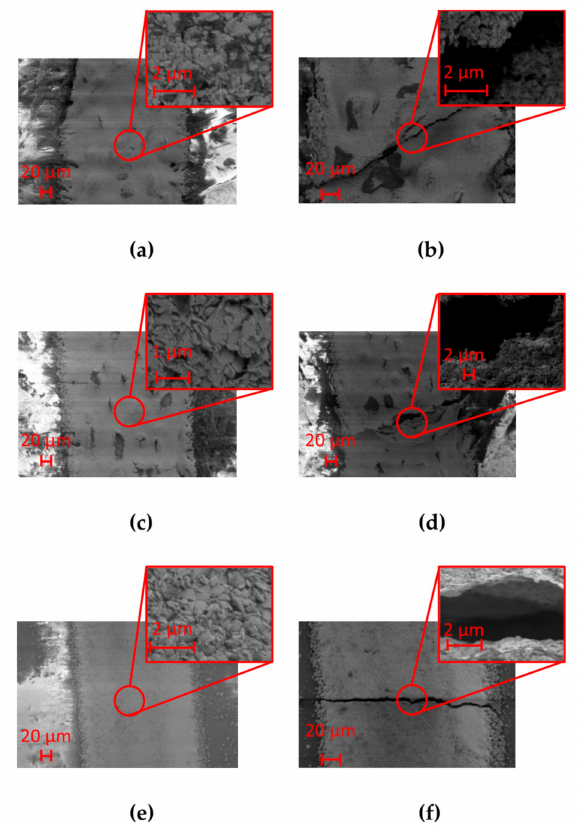
Figure 10. SEM magnifications of ( a ) chromatographic paper before bending, ( b ) chromatographic paper after bending, ( c ) cardboard before bending, ( d ) cardboard after bending, ( e ) photopaper before bending, ( f ) photopaper after